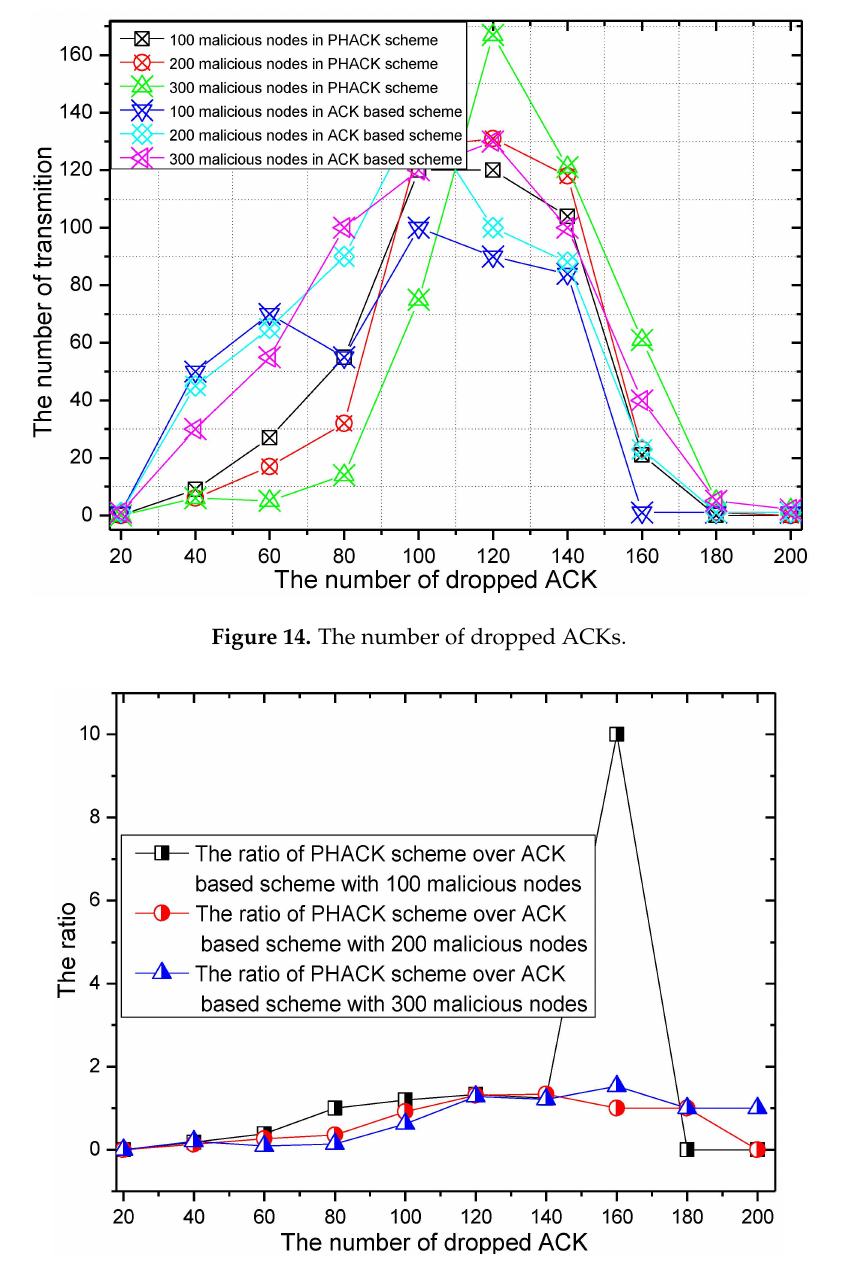
Figure 15. The ACK dropratio of PHACK over theACK-based